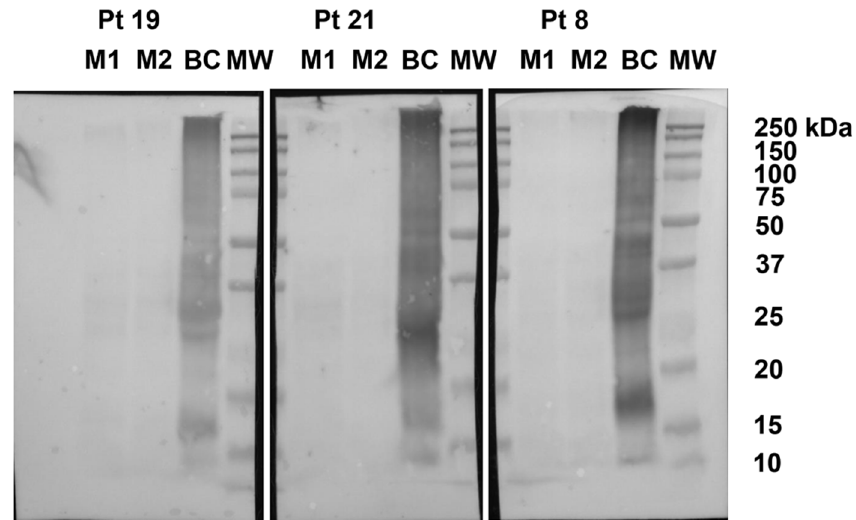
Figure 2. Representative immunoblots. Proteins extracted from two doses (M1 and M2) of biscuit tested on patients (Pt) 19, 21, and 8, blotted with the corresponding patient serum. Proteins extracted from biscuits containing egg and milk ingredients (BC) were loaded as positive control. MW: protein molecular weight standards.